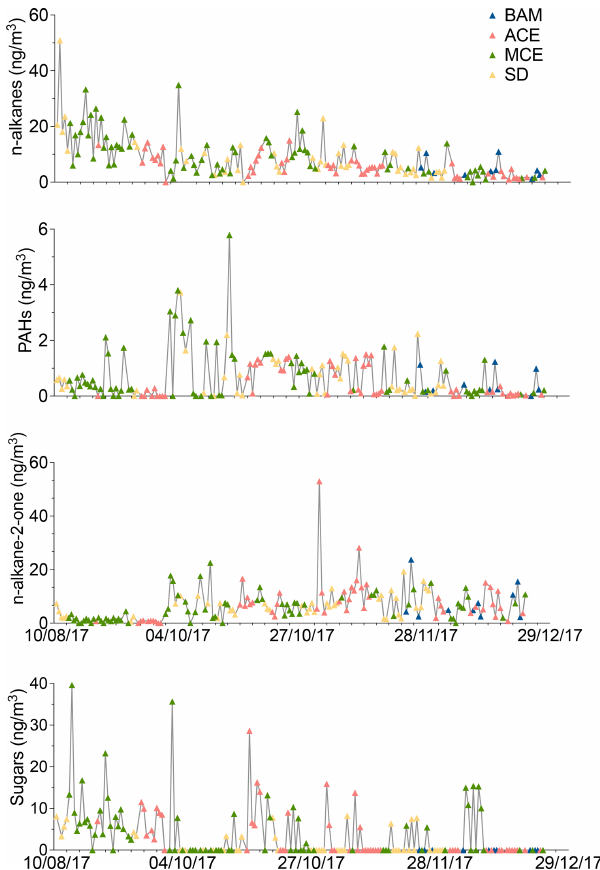
Figure 6. Time series of organic compounds in PM 10 filter samples collected from August to December 2017 at AMV. The color of the symbols displayed for each sample represents a specific air mass origin: background (blue); ACE (red); MCE (green); SD (yellow).